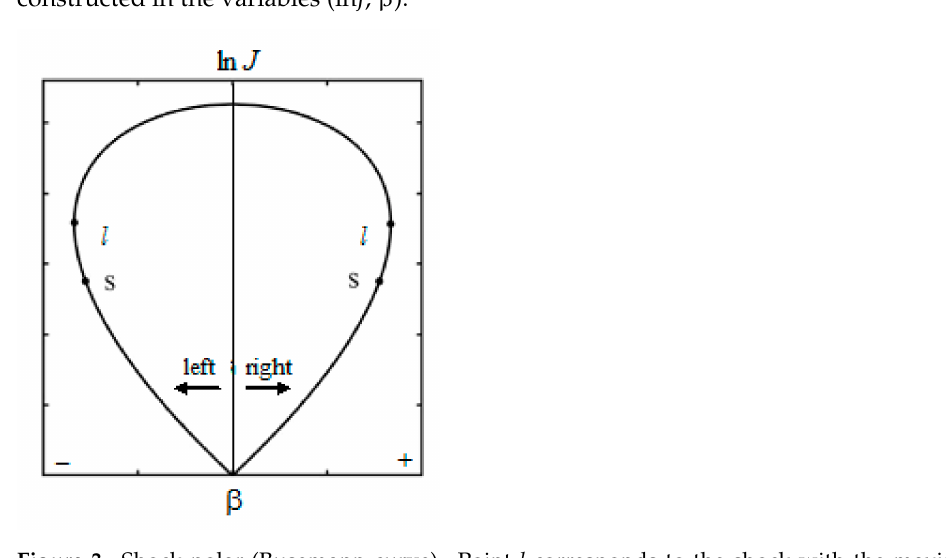
Figure 3. Shock polar (Busemann curve). Point l corresponds to the shock with the maximum possible flow turning angle, and point s is the sonic